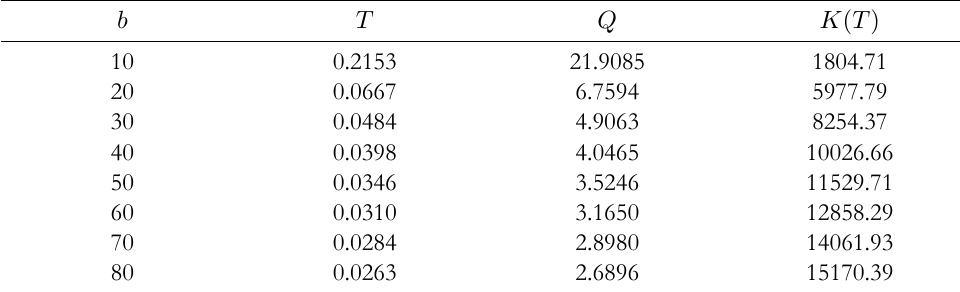
Table 3: Variation in T; Q & K ( T ) with coefficient (b)